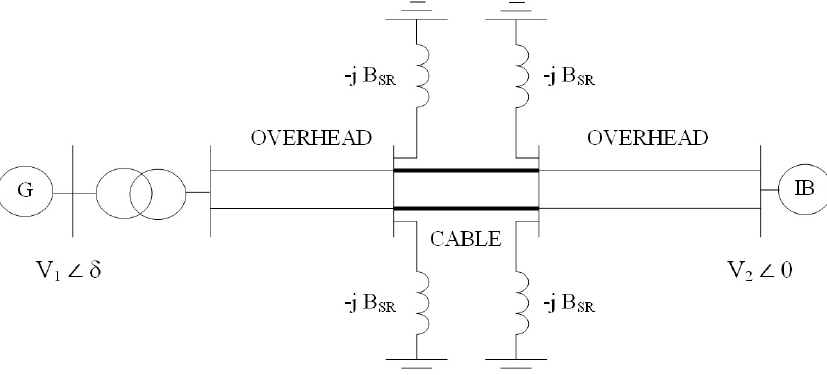
Figure 1. Simple test system: one synchronous machine is connected to infinite bus through a double-circuit mixed overhead-cable line. The mixed line is compensated with four shunt reactors of 220 MVAR each, installed at the cable ends.